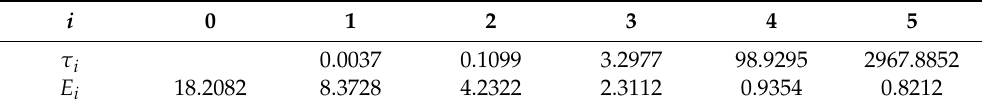
Table 3. The first 5 order parameters of Prony